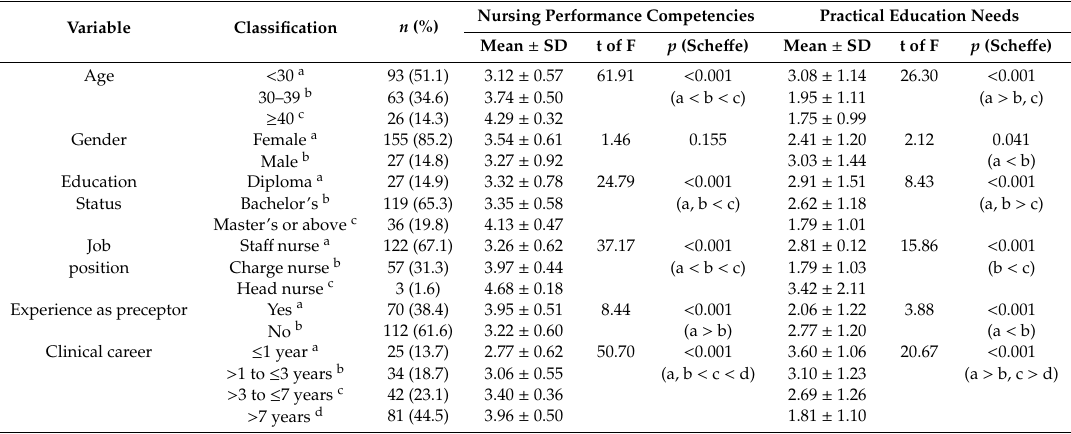
Table 2. Nursing performance competencies and practical education needs by demographic characteristics ( n = 182).